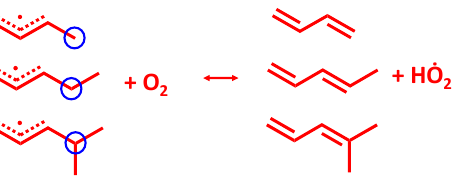
Figure 2. Reaction class for primary, secondary, and tertiary H-atom abstraction from C4, C5, and C6 allylic radicals, respectively.